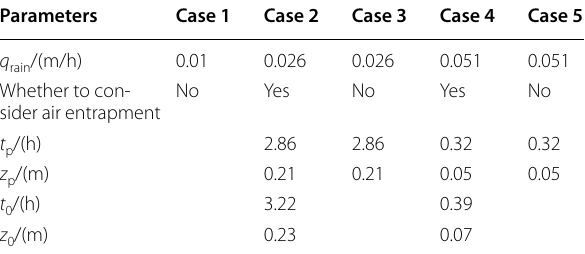
Table 7 Time-delay effect of infiltration